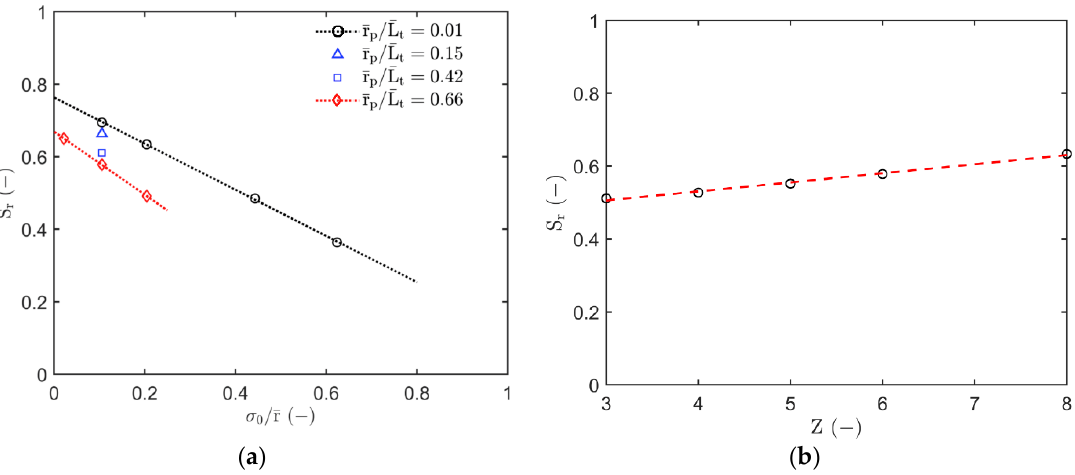
Figure 3. Residual saturation as a function of ( a ) ratio of the standard deviation of throat size distribution (TSD) over mean throat radius. Data denoted by (‘o’) have been obtained for the networks with 𝜎 0 /𝑟 ̅ = 1/10 (µm), 2/20 (µm), 5.2/11.8 (µm), 9.1/14.6 (µm). Other data have been recorded: ‘Δ’ with 𝜎 0 /𝑟 ̅ = 10/100 (μm), ‘□’ with 𝜎 0 /𝑟 ̅ = 20/200 (μm) and ‘◊’ with 𝜎 0 /𝑟 ̅ = 25/250 (µm). The center distance between two pores was L = 1000 µm. 𝑟̅ 𝑝 is the mean radius of pores in the network. Throat length ( L t ) is calculated based on neighbor pores and averaged throat length ( 𝐿̅ t ) is averaged o ver all throats in the network. The connectivity (Z) was 6; ( b ) connectivity at constant ratio 𝜎 0 /𝑟 ̅ = 25/250 (µm). The connectivity presents the averaged connectivity of pores for the whole network. The simulation values are averaged over 40 realizations.